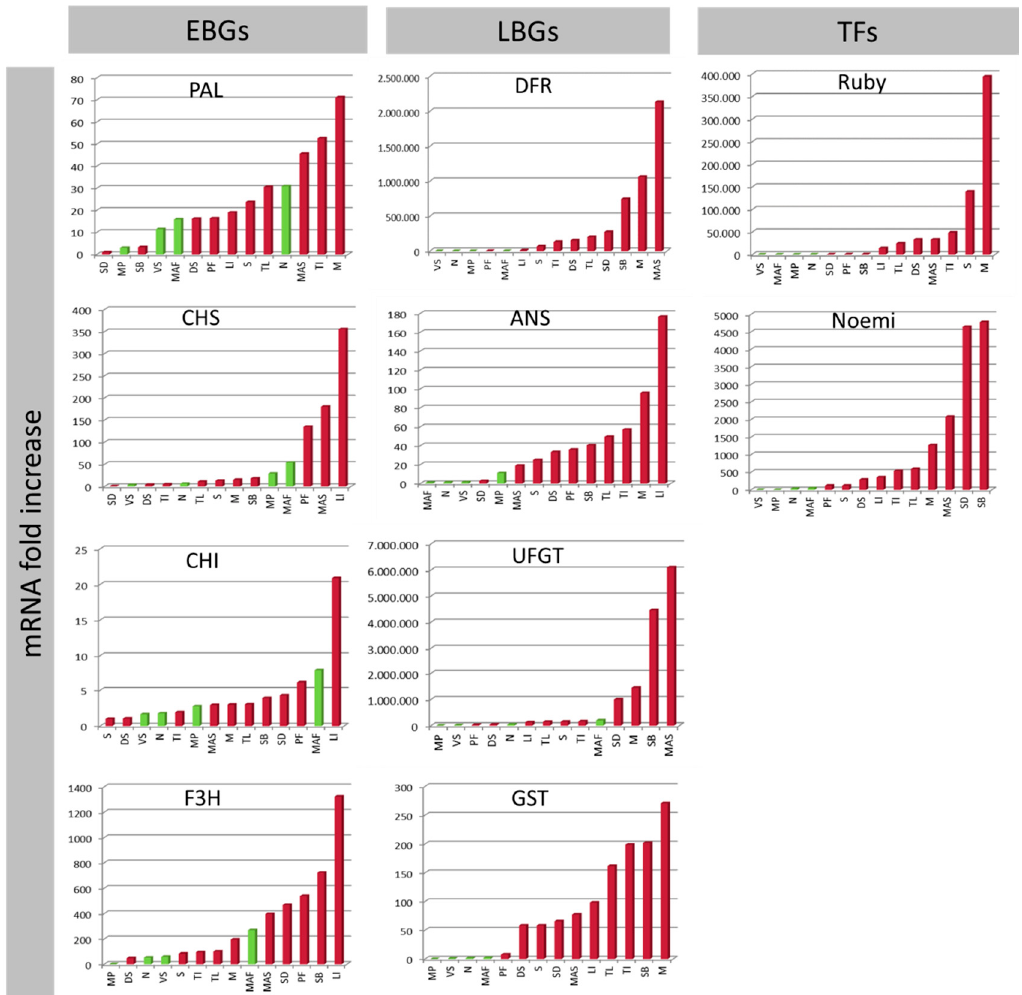
Figure 7. qRT-PCR expression data for all structural genes in the rind separated into Early Biosynthetic Genes (EBGs), Late Biosynthetic Genes (LBGs) and Transcription Factors (TFs). The expression level was calculated as the mRNA -fold increase. Each accession is coded: M. paniculata —